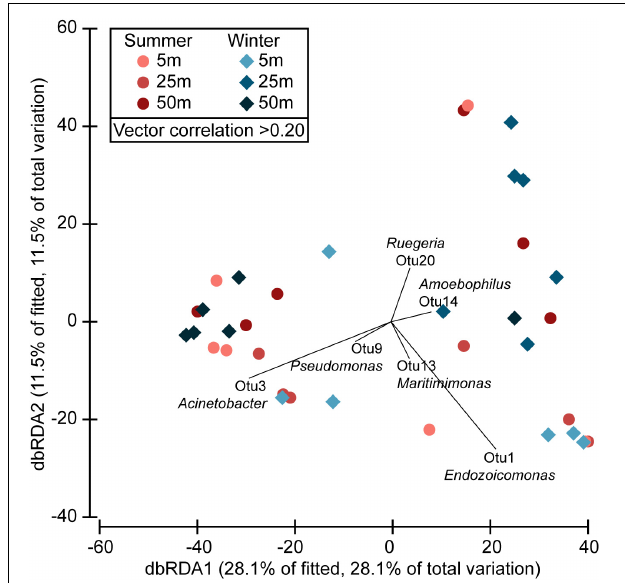
FIGURE 4 | Differences in the diversity of the Stylophora pistillata microbiome. Beta diversity of the microbiota of S. pistillata collected along a depth gradient (5, 25, and 50 m) in summer and winter is presented in a distance-based redundancy analysis (dbRDA) ordination plot. Correlation vectors indicate the main bacterial groups driving the differences